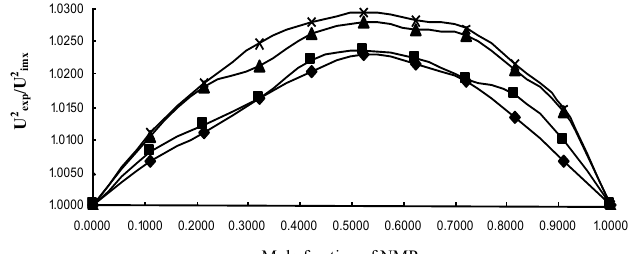
Figure 1. Variation of U 2